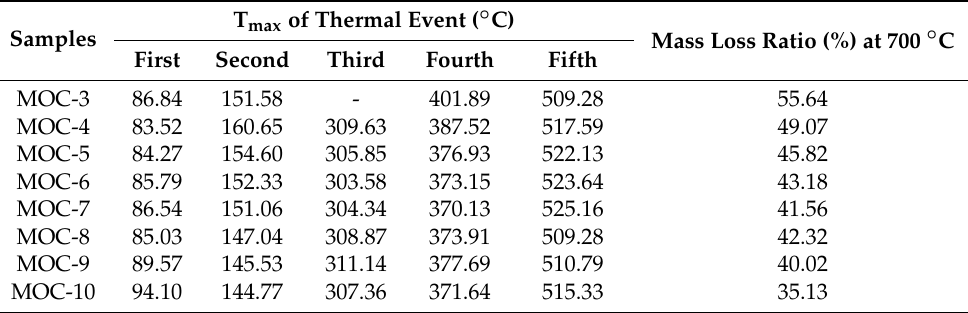
Table 3. Thermo-degradation data of the MOC